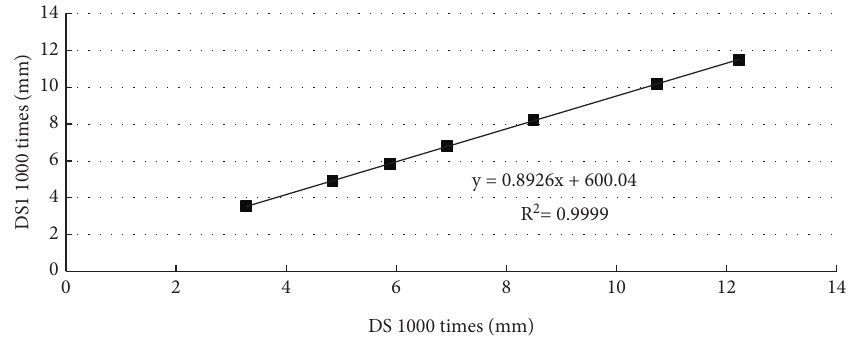
Figure 5: DS-temperature curves of the two